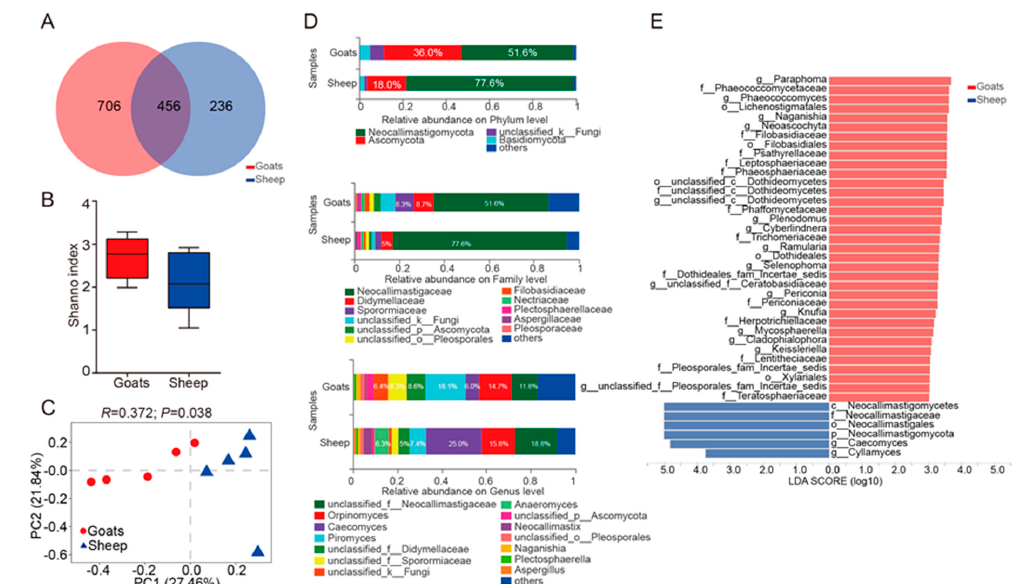
Figure 2. Diversity and composition of ruminal fungi in goats and sheep. ( A ). Mutual and particular operational taxonomic unit (OTU) number of fungi in goats and sheep. ( B ). Comparison of the diversity estimation of the fungi based on One-way ANOVA, in which the y -axis represented Shannon index. The Shannon index was related to the richness and evenness of the microbial community. ( C ). Principal coordinate analysis (PCoA) profile of fungi diversity in all samples using an unweighted UniFrac metric. The percentage of variation explained by PC1 and PC2 were indicated in the axis X and Y. Statistic (R) and p -value (P) were annotated by ANOSIM analysis between goats and sheep. ( D ). The illustration exhibited the relative distribution of the most dominant fungi (1% of the total sequences) in goats and sheep at the phylum, family, and genus level. ( E ). Taxa with significantly different abundances at phylum (p), class (c), order (o), family (f), genus (g) levels are shown. The red color represented that the abundance of taxa was higher in goats and a blue color represented that the abundance of taxa was higher in goats. The higher the Linear Discriminant Analysis (LDA) score, the greater the effect of the taxa abundance on the difference between goats and sheep.